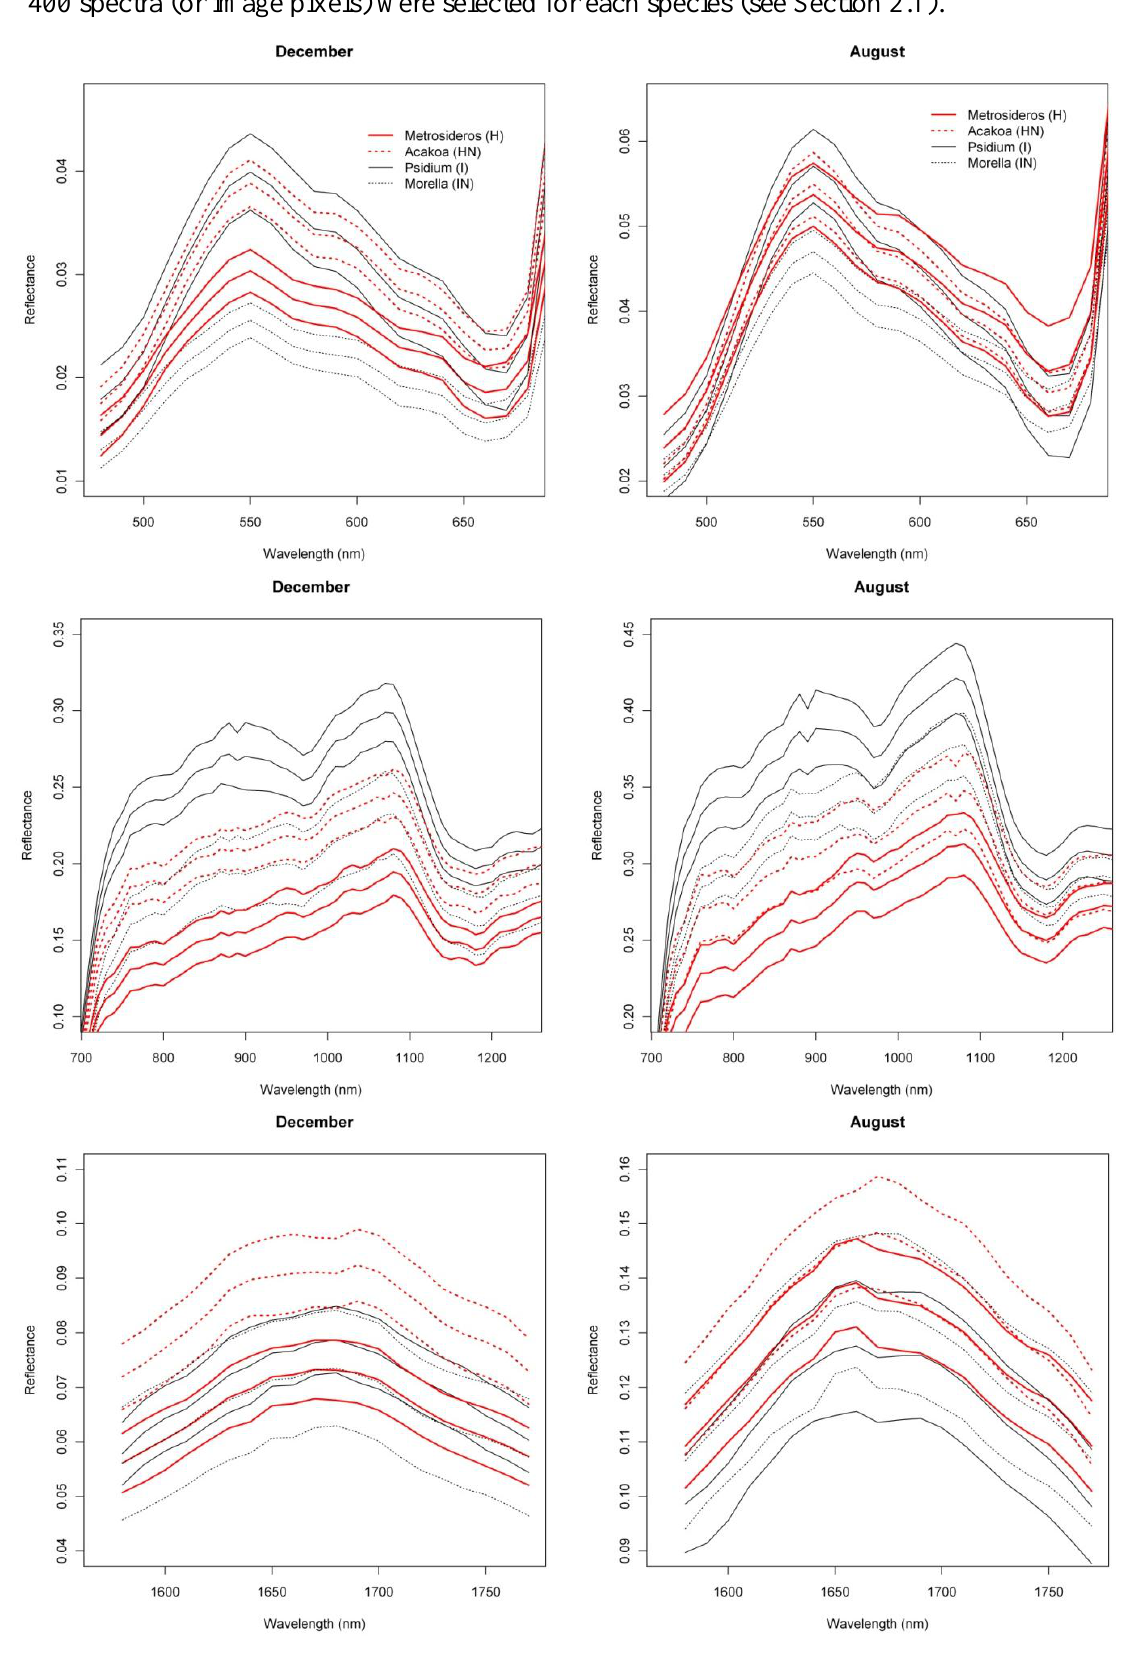
Figure 6. Mean and 95% confidence interval for December and August reflectance of native and invasive species for the visible, near-infrared and shortwave-infrared. Approximately 400 spectra (or image pixels) were selected for each species (see Section